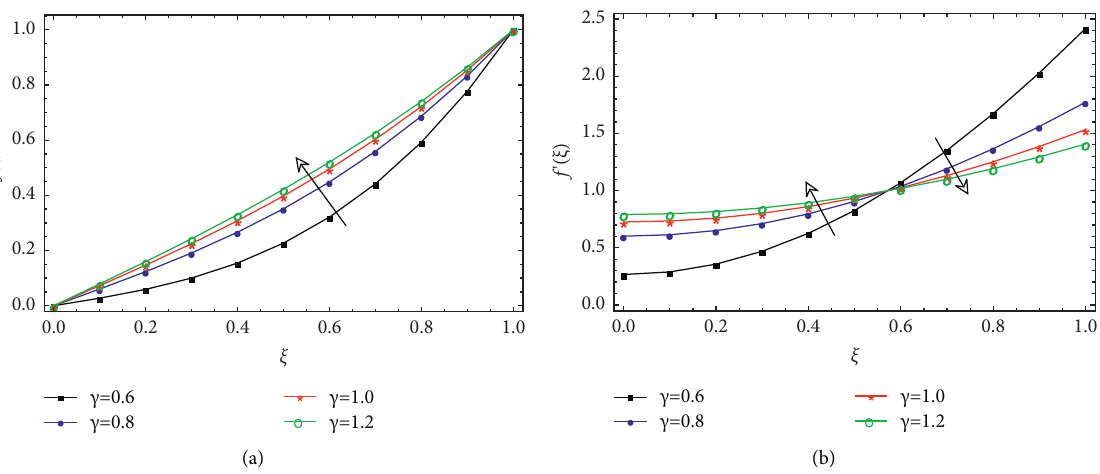
Figure 10: Effect of M P on the velocity profile keeping (b) Axial component of velocity.